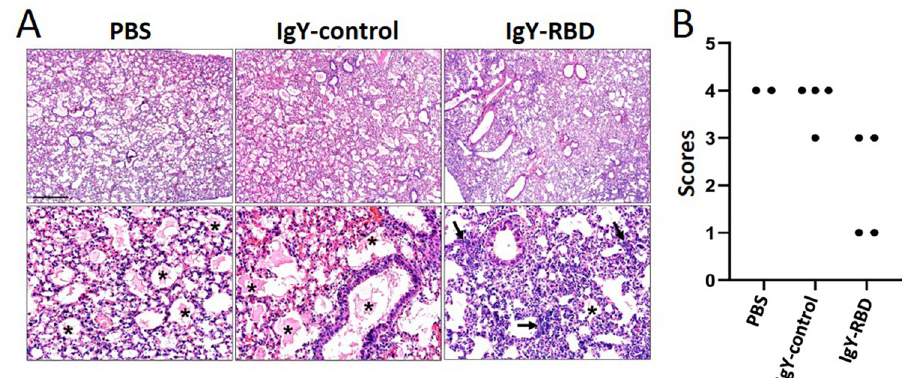
Fig 8. IgY-RBD diminishes pathological changes in mice infected with SARS2-N501Y MA30 . Lungs were harvested from mice treated with PBS, IgY-control or IgY-RBD at 5dpi. (A) Pulmonary edema ( � ) was widespread in PBS and IgY-control groups but was detected less in IgY-RBD-treated mice. Increased cellular infiltrates (arrows) in interstitial and perivascular regions were seen in the IgY-RBD group. HE stain, Bar = 480 and 95mm, top and bottom panels, respectively. (B) Ordinal scoring of lung edema. The median scores of the three groups varied significantly (P = 0.0317, Kruskal-Wallis test) and IgY-RBD trended to have reduced edema compared to PBS and IgY-control groups (P = 0.0892 and P = 0.0935, respectively, Dunn’s